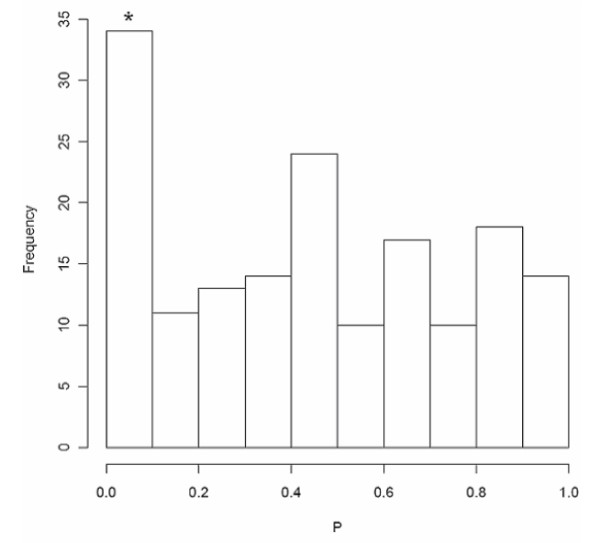
Distribution of P-values of regulatory SNPs within KEGG cancer pathways (pathway identifiers beginning with hsa052*). *Global P-values of cancer-related regulatory SNPs with P < 0.05 in the genome-wide association analysis using the admixture maximum likelihood test (5,000 permutations) are 0.0028 (unadjusted), and 0.052 (with adjustments made to correct for population stratification).